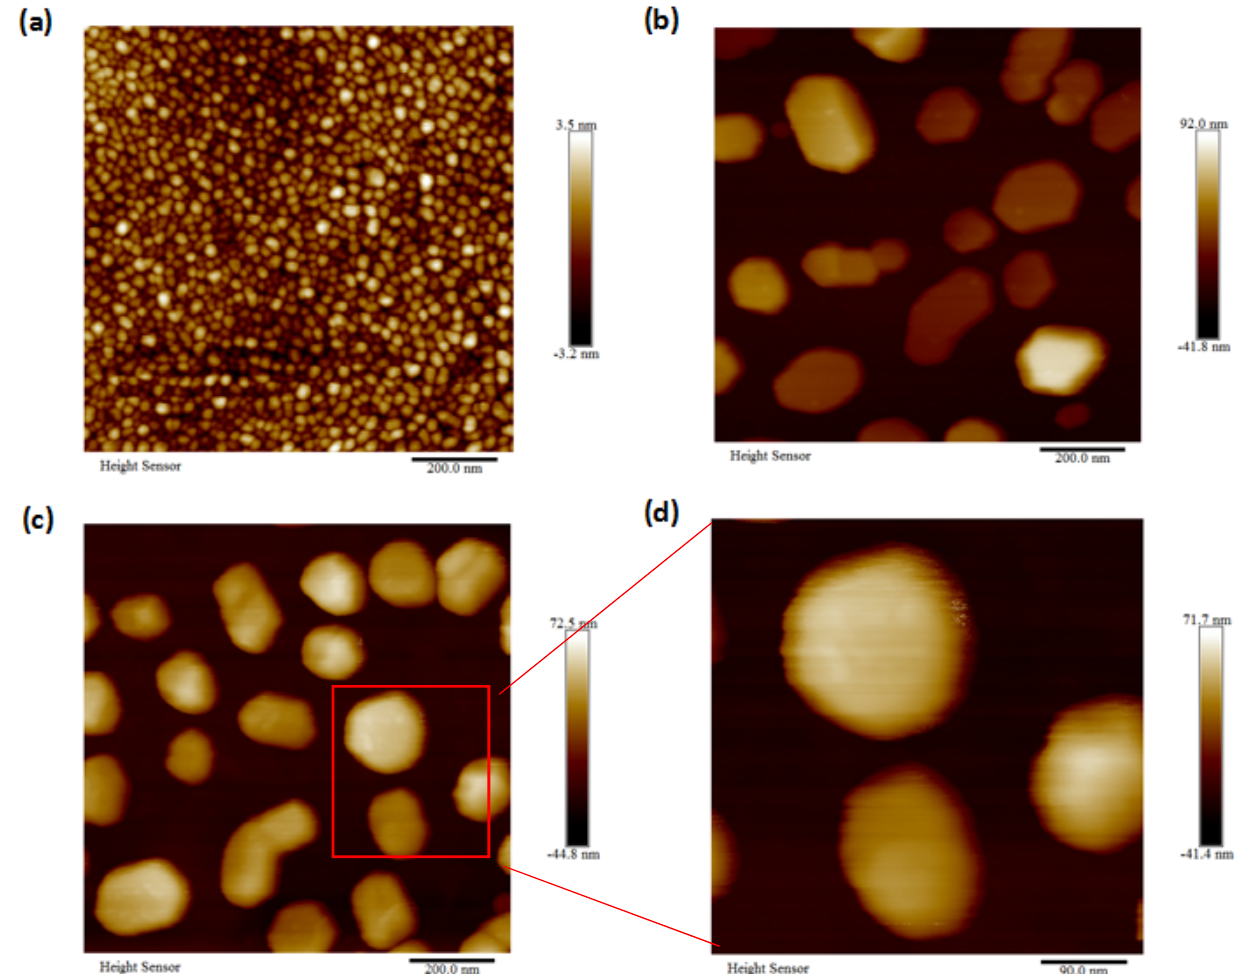
Figure 1. AFM images of the gold nanoparticles on samples S1, S2, and S3. ( a ) Gold nanoparticles on the surface of sample S1. ( b ) Gold nanoparticles on the surface of sample S2 ( c , d ) Gold nanoparticles on the surface of sample S3.